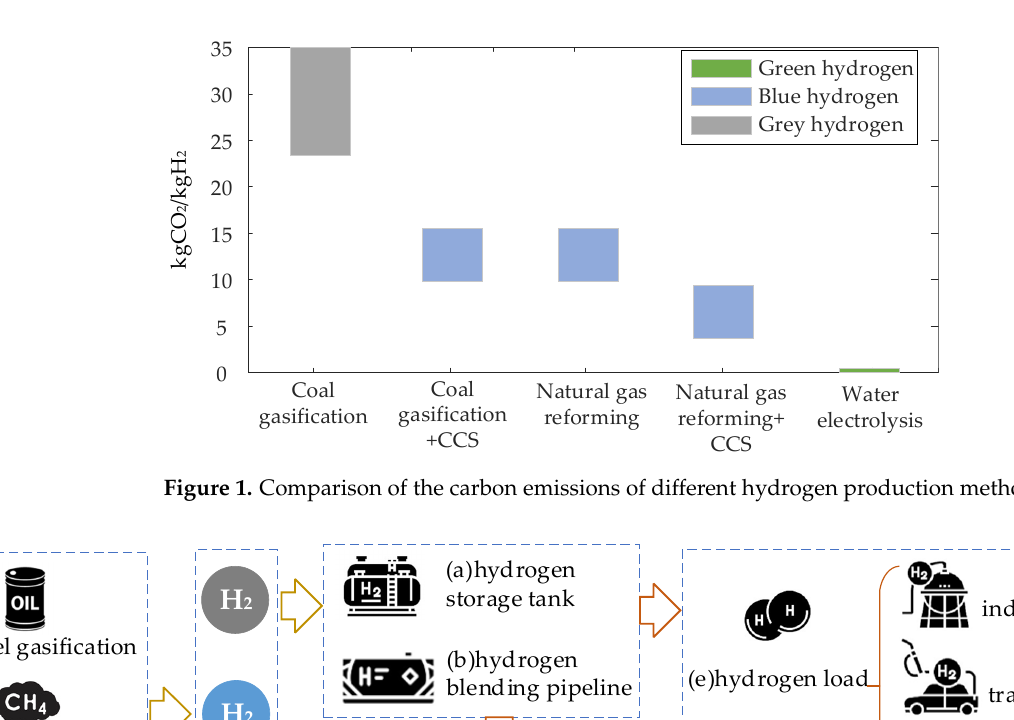
Figure 1. Comparison of the carbon emissions of different hydrogen production methods.